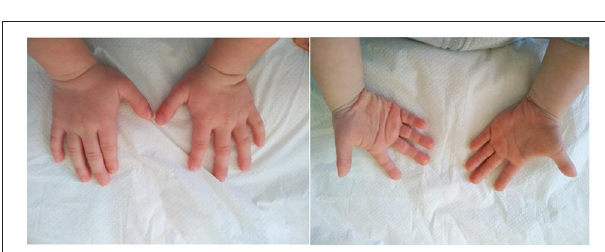
FIGURE 4 | The hands of the patient with a 16q24.2q24.3 microdeletion. Note a